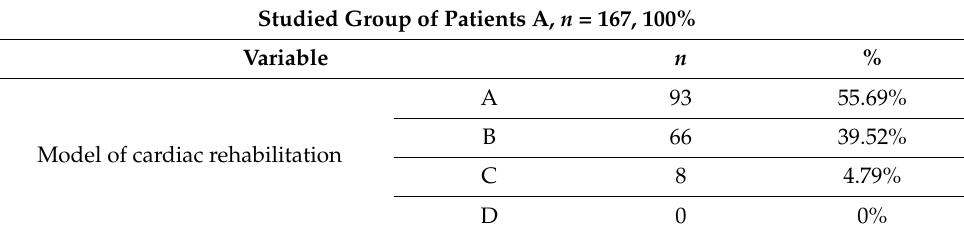
Table 2. The characteristics of the studied group of patients after myocardial infarction participating in early post-hospital cardiac rehabilitation (A), including the rehabilitation model. Studied Group of Patients A, n = 167, 100% Variable n % A 93 55.69% B 66 39.52% Model of cardiac rehabilitation C 8 4.79% D 0